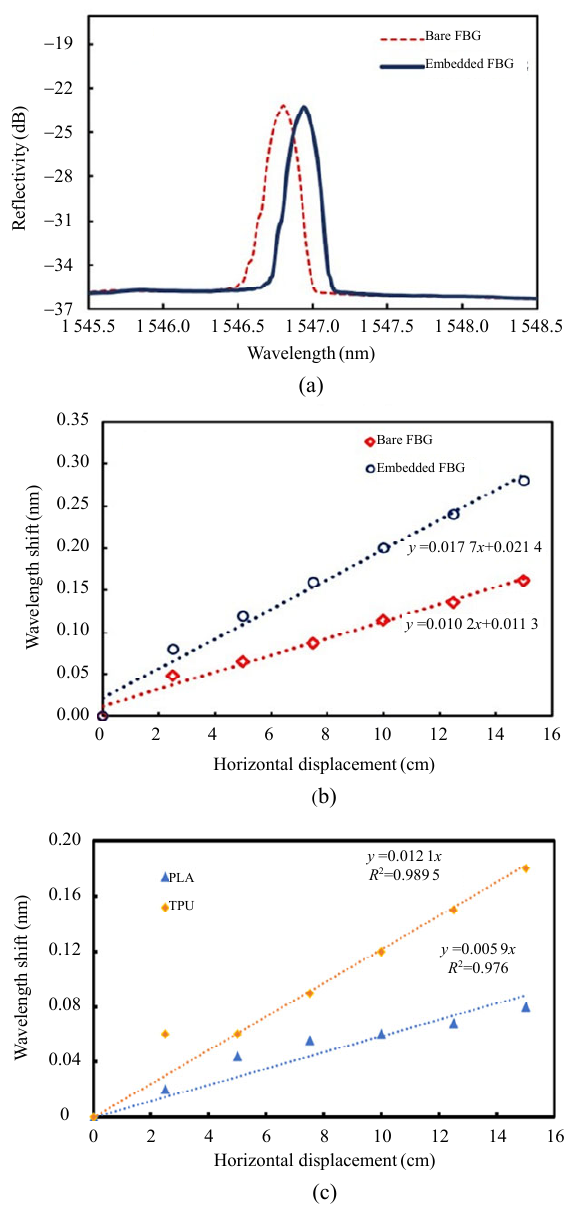
Fig. 6 Illustration of the spectra of (a) the bare FBG (dashed, red) and the embedded FBG (solid, blue), (b) graph of the calibration of both the bare (red) and embedded (blue) FBGs (as seen in Fig. 3), and (c) comparison of sensing performance between TPU-based strain sensor and PLA-based strain